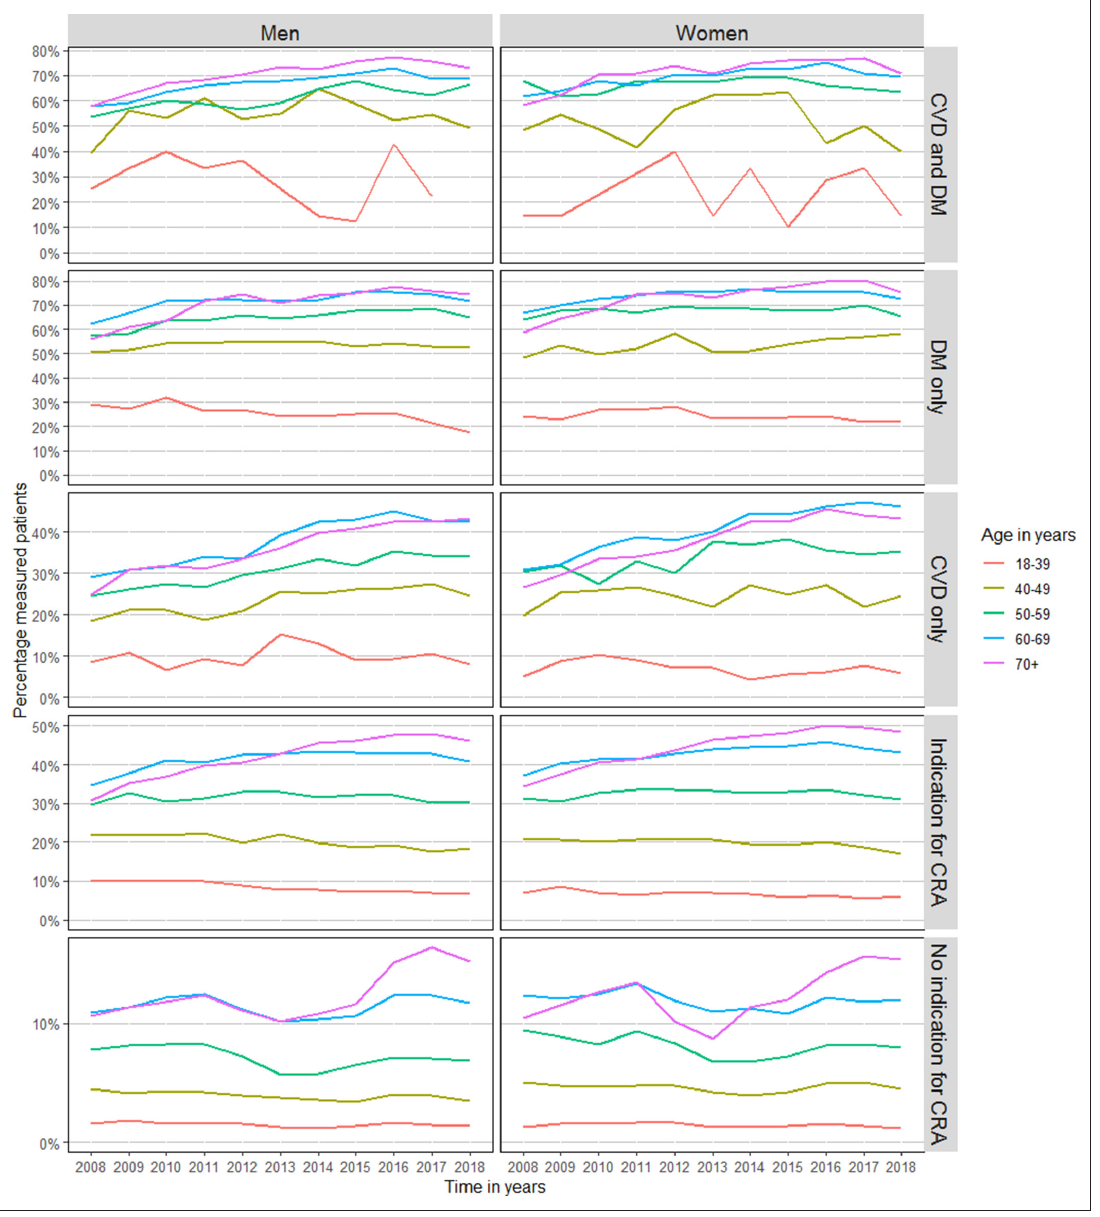
Figure 3 Sex and age stratified trends in annual cholesterol measurement in patients with a history of CVD, DM, indication for CRA, or without an indication for CRA. CRA = cardiovascular risk assessment. Patients were classified as ‘Indication for CRA’ if they did not have a history of CVD or DM, but did have a history of one of the following: rheumatoid arthritis, pre- eclampsia, pregnancy- induced DM, family history of CVD, obesity, smoking, hypertension, dyslipidaemia, chronic kidney disease, use of antihypertensive or lipid- lowering medication. CVD = cardiovascular disease. DM = diabetes